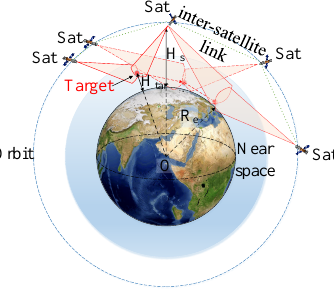
Figure 3. The LEO constellation warning system collaborative